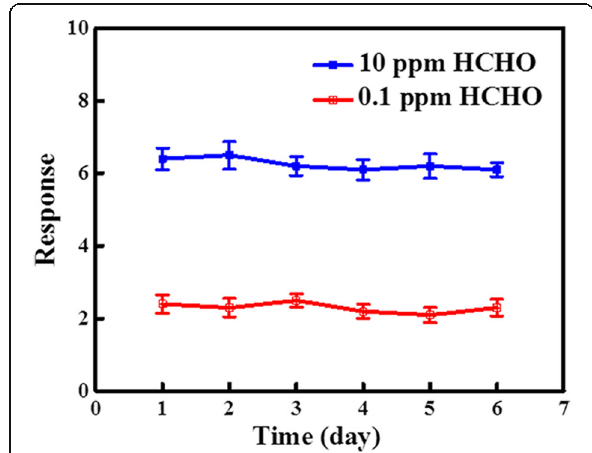
Fig. 5 Stability test of n-SiNWs and RGO@n-SiNWs for 0.1 ppm and 10 ppm